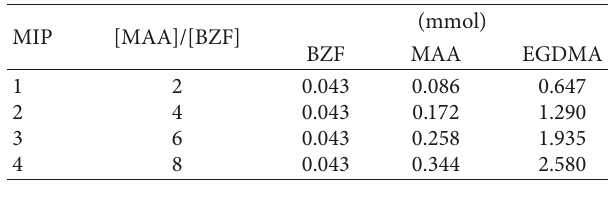
Figure 4: OXA first-order absorption derivative spectra after complete hydrolysis. [OXA] Table 1: Polymers synthesized maintaining a 7.5 EGDMA/MAA molar ratio.